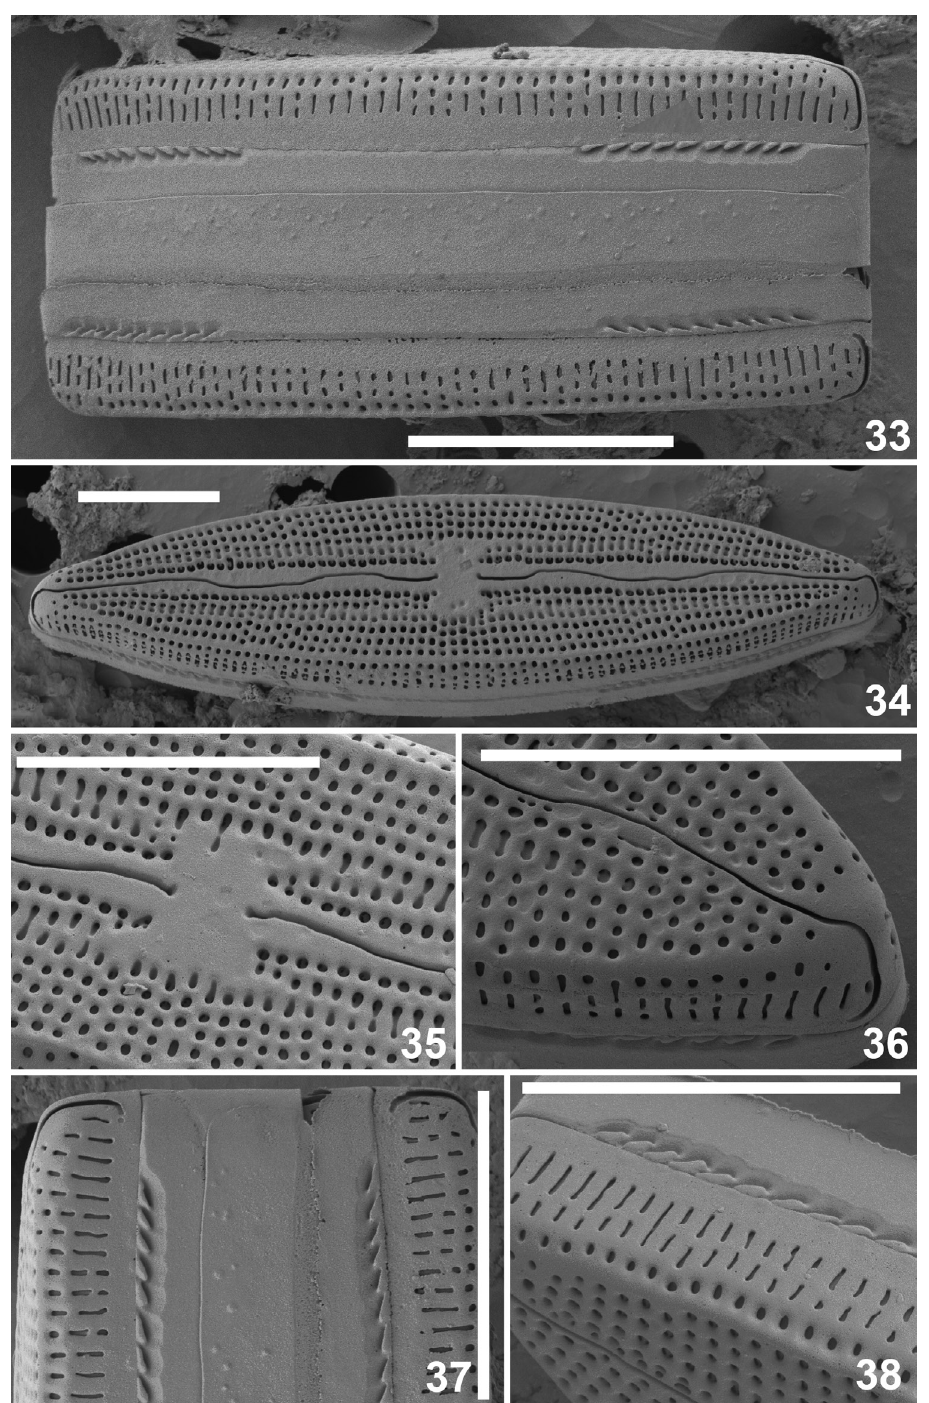
Figs 33–38. Mastogloia belaensis M.Voigt. Scanning electron micrographs (SEM) of valves from the Lac de Guiers population ( Van de Vijver sample SEN-42 ). 33 . SEM girdle view of an entire frustule showing the partectal pores and the mantle areolae. 34 . SEM external view of an entire valve with typical undulating raphe branches. 35 . SEM external detail of the central area. 36 . SEM external detail of the valve apex. 37 . SEM external detail of the apices and girdle bands of an entire frustule. 38 . SEM external detail of the valve mantle with the transapically elongated mantle areolae and the row of rounded pseudoloculi on the valve face/mantle junction. Scale bars: 10